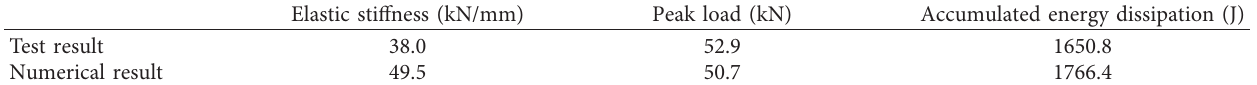
Table 2: Mechanical parameters obtained from experimental and numerical results.